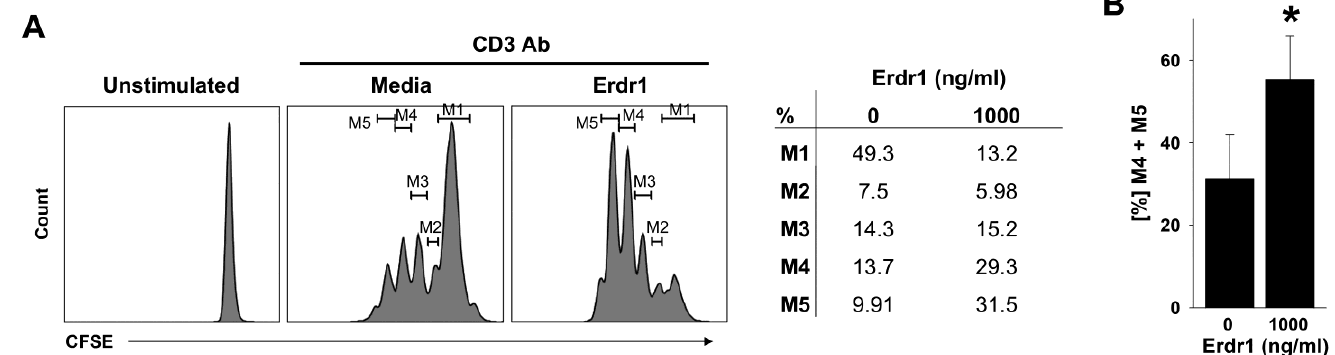
Figure 2. Erdr1 enhances the proliferation of CD4 T cells. ( A ) CD4 T cells from peripheral lymph nodes were labeled with CFSE (1 μ M) and cultivated with or without 1 μ g/mL of Erdr1 in the pres- ence of the anti-CD3 ε antibody (500 ng/mL). The unstimulated control was incubated without the anti-CD3 antibody. After 72 h cultivation, T cell proliferation was evaluated by the flow cytometric analysis. ( B ) Two of the most divided populations (M4 and M5) were summarized as mean ± SD. The flow cytometric results are representative of data from three independent experiments. * p < 0.05 (vs. Erdr1 0 ng/mL).